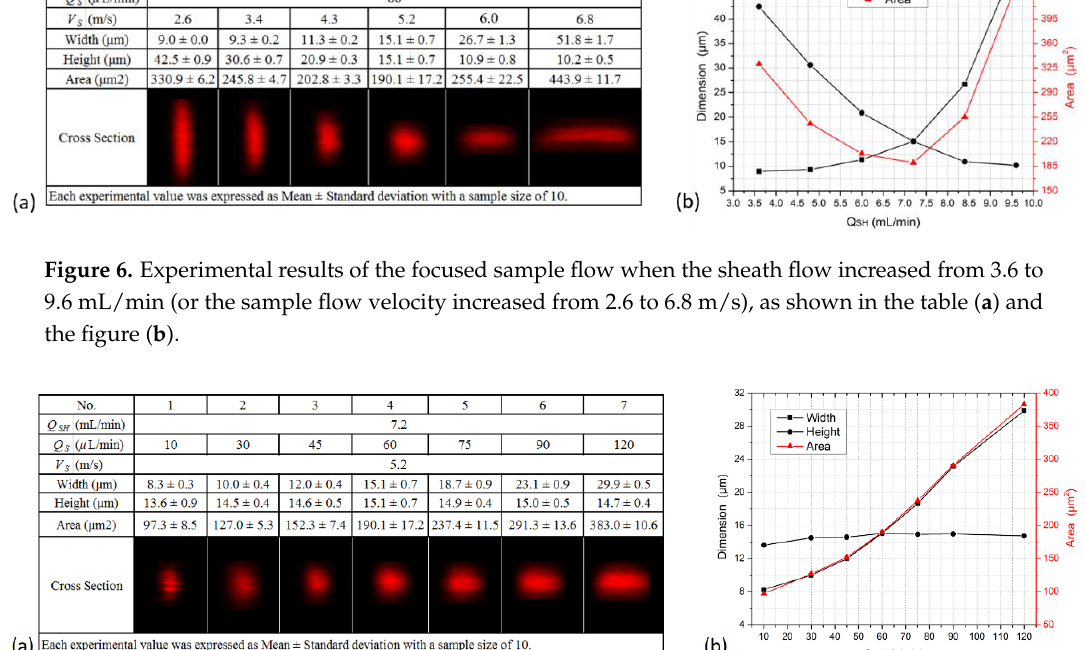
Figure 7. Experimental results of the focused sample flow when the chip operated at a constant velocity of 5.2 m/s and the sample flow rate increased from 10 to 120 μL/min, as shown in the table ( a ) and the figure ( b ).